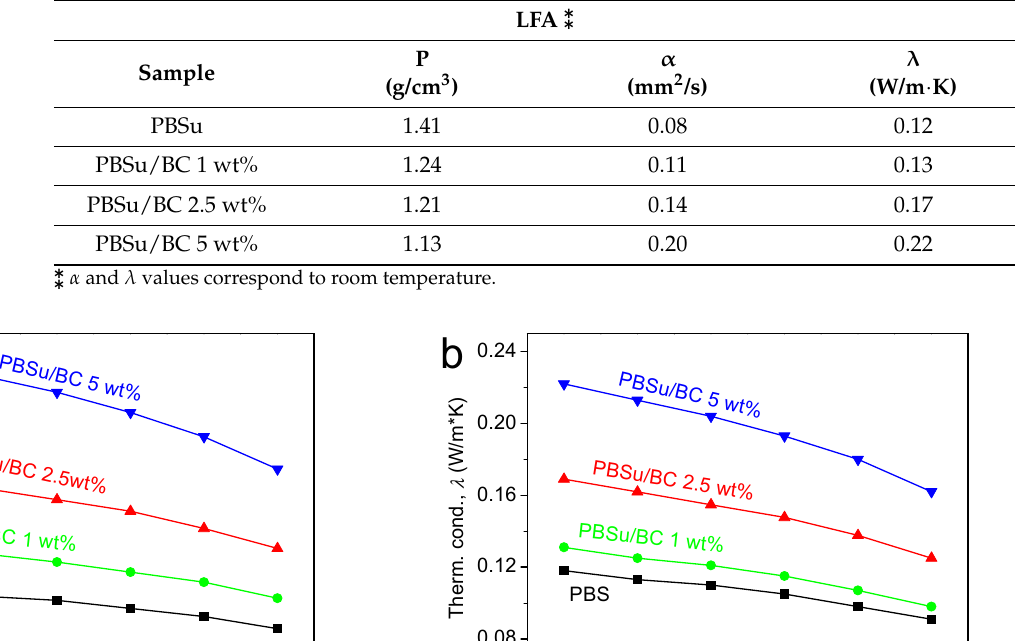
⁑ α and λ values correspond to room temperature.